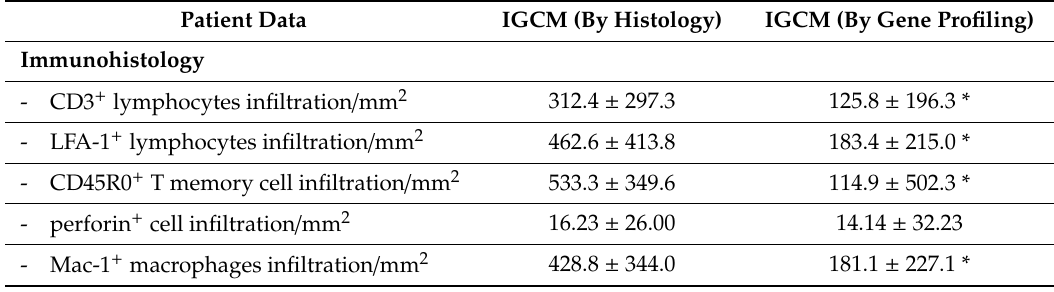
Table 3. Immunohistologic EMB Analysis of Intramyocardial Infiltration in GCM Patients Based on Conventional Histology or on Gene Profiling.